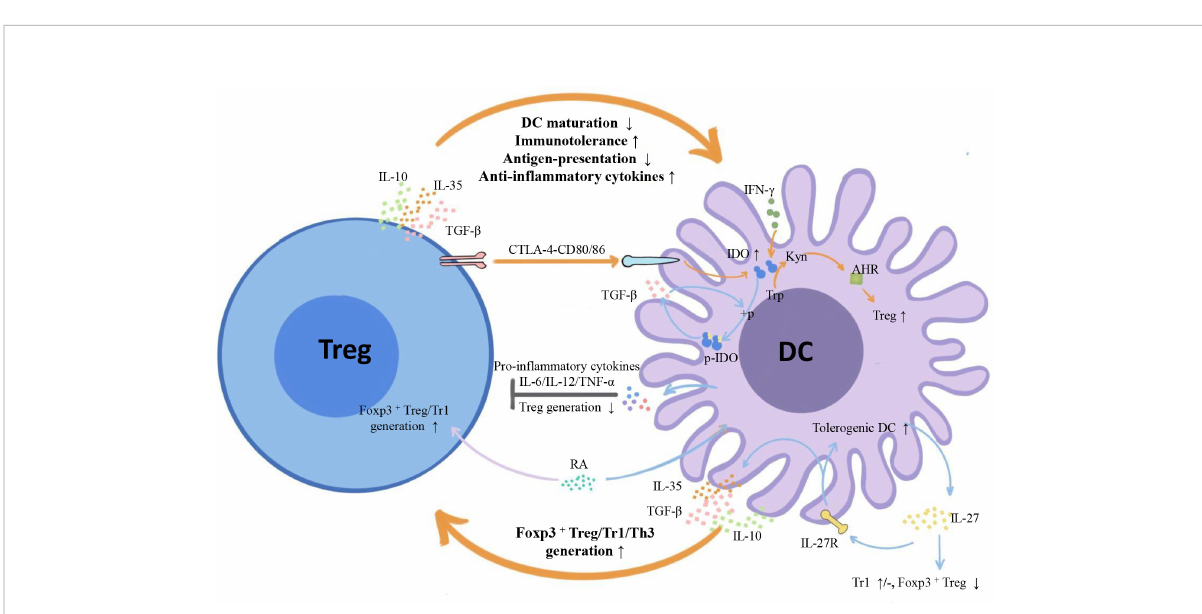
FIGURE 3 Inhibitory cytokines and metabolic enzymes involved in DC-Treg cell crosstalk. From the perspective of cytokines, both DCs and Tregs can secrete inhibitory cytokines IL-10/IL-35/TGF- b and form inhibitory feedback mechanisms: DCs promote the generation of different subtypes of Tregs, and Tregs inhibit the maturity and antigen presentation ability of DCs and improve their tolerance. From the perspective of metabolic enzymes, Tregs can induce IDO expression in DCs with the help of signals axes, such as CTLA-4-CD80/86, initiate the tryptophan metabolic pathway, trigger the generation of IDO-dependent Tregs, and form a negative feedback loop with IDO at the core. There is also unidirectional regulation of Tregs by DCs: DCs in fl uence Treg generation by secreting IL-27, and IL-12/IL-6/TNF- a inhibits Treg cell proliferation. TGF- b , transforming growth factor- b ; IFN- g , Interferon- g ; IDO1, indoleamine 2,3-dioxygenase 1; + p, phosphorylation; P-IDO1, phosphorylated indoleamine 2,3-dioxygenase 1; Trp, tryptophan; Kyn, kynurenine; AHR, aromatic hydrocarbon